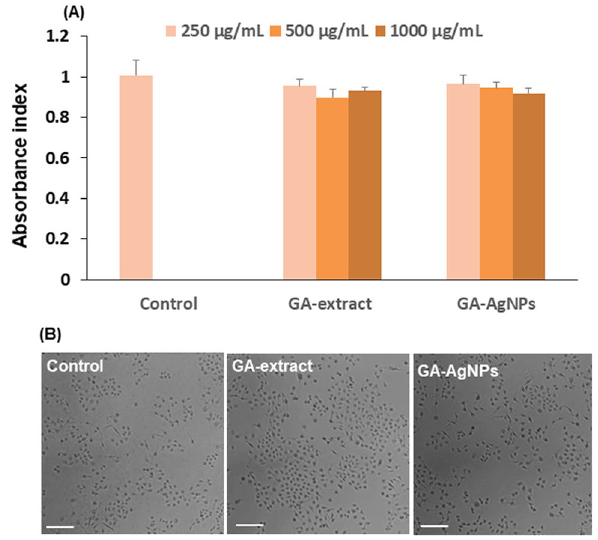
Figure 8. In vitro cytotoxic effect of GA-AgNPs: ( A ) MTS assay and ( B ) optical microscopic image on chang liver cell lines (scale bar 200 µm). Data represent mean value ± standard deviation. *p <